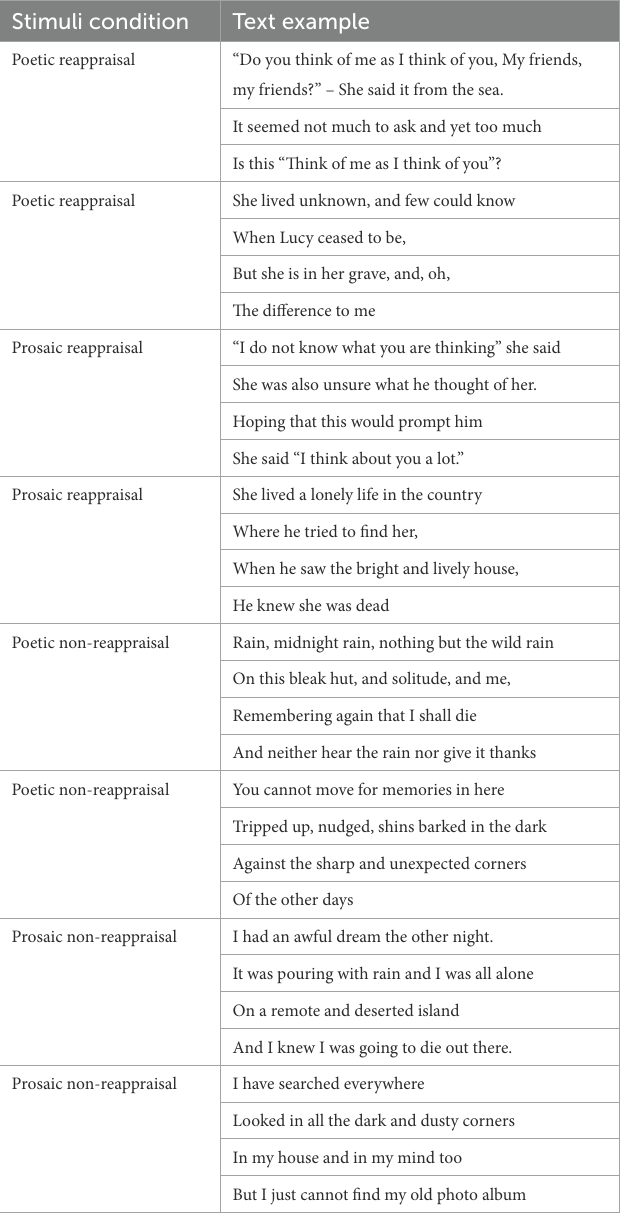
TABLE 1 Examples of text stimuli by condition (N.B. the whole stimuli set is available from the authors by request). Stimuli condition Text